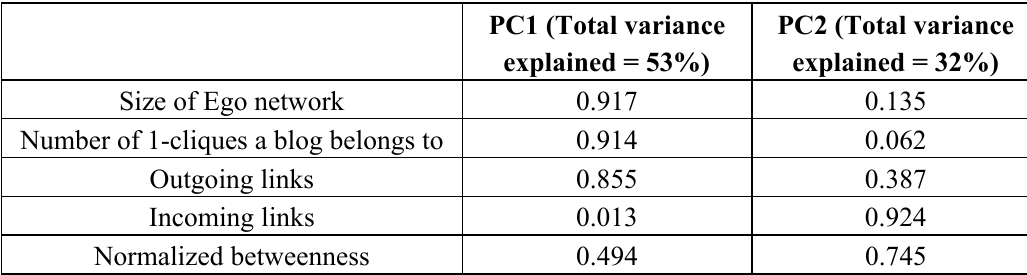
Table 3. Factor loadings of the Principal Components constructed form the five social network indexes (Varimax